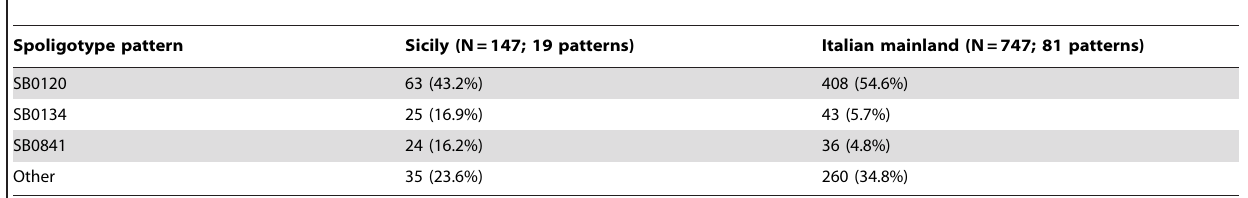
Table 4. Mycobacterium bovis spoligotype patterns identified from Sicily (this study) and mainland Italy (adapted from Boniotti et al.